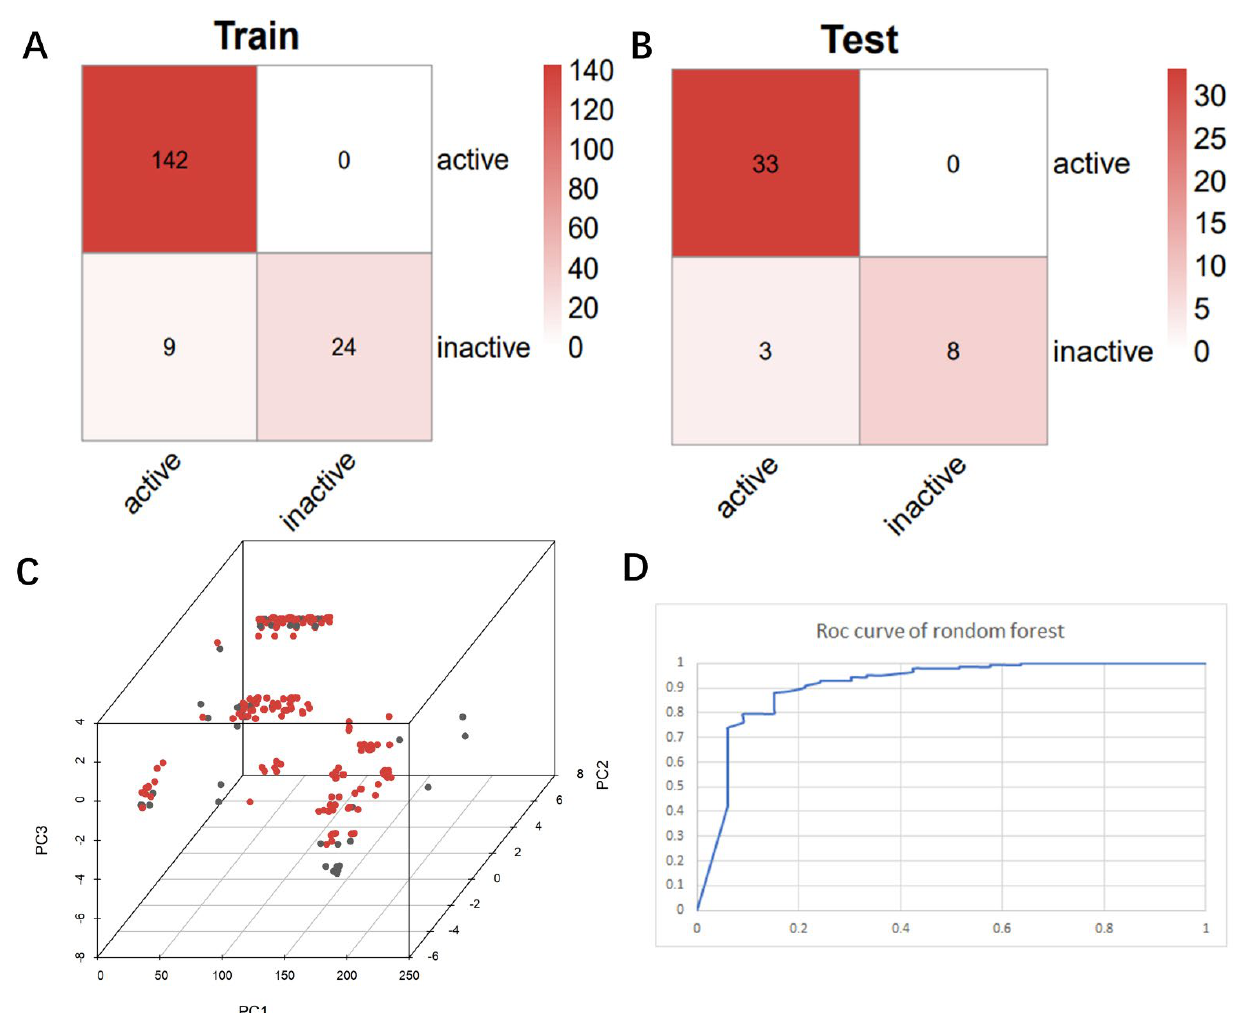
Figure 4. Chaos matrix and roc curve of the constructed random forest classifier and the chemical space of the candidate mangrove compound library. ( A ) Confusion matrix of random forest classifier to distinguish the training set; ( B ) confusion matrix of random forest classifier to distinguish the test set; ( C ) chemical space of the candidate compound library; ( D ) ROC curve of the random forest classifier. Table 1. Prediction values for the training set for the random forest classifier.